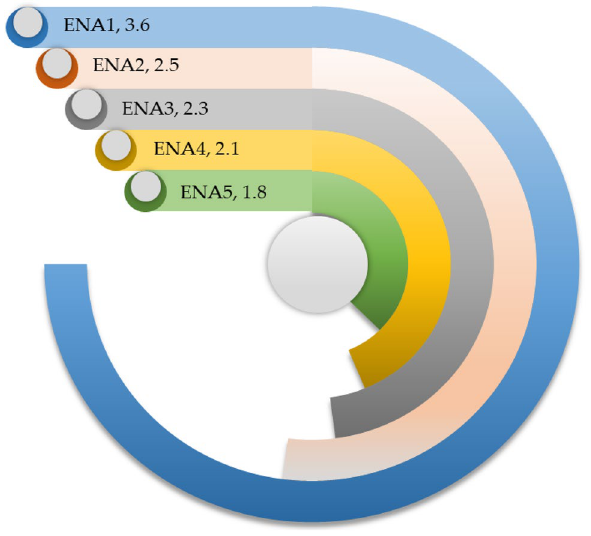
Figure 8. Sustainability evaluation of ELV recycling system from environmental